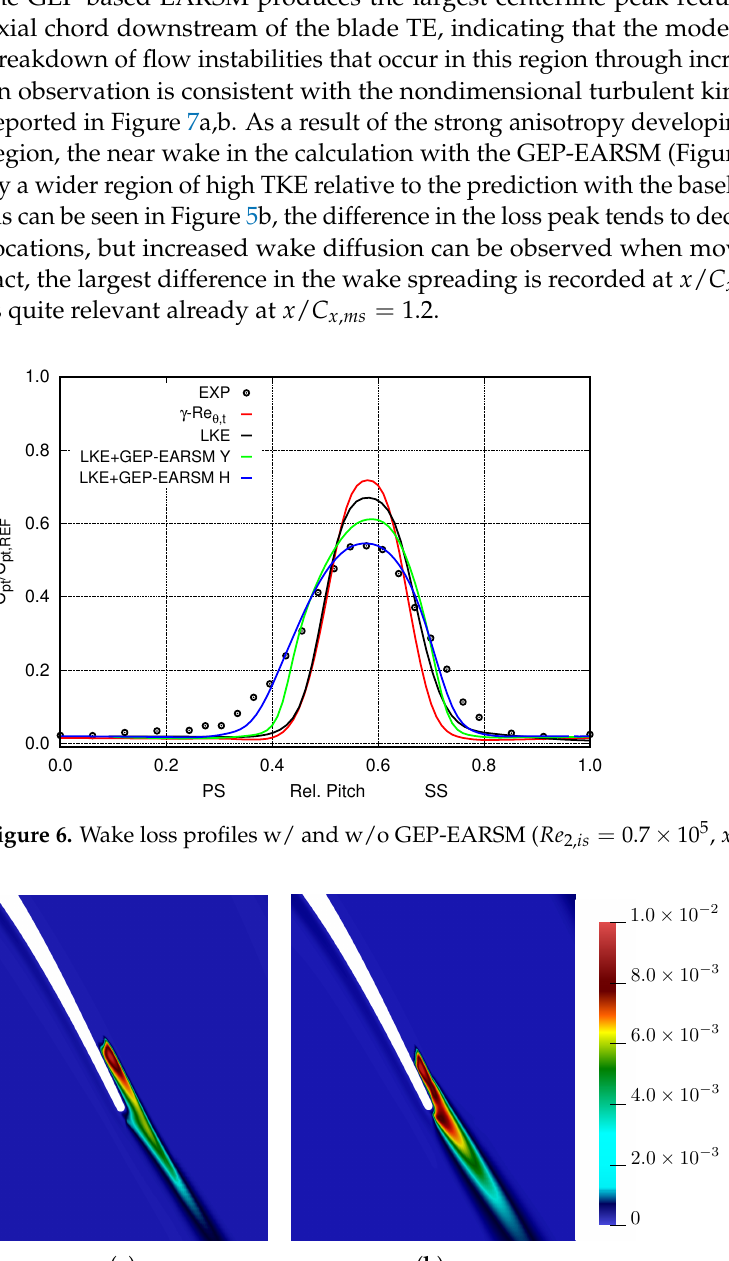
Figure 7. Nondimensional turbulent kinetic energy at midspan ( a ) without GEP-EARSM ( b ) with GEP-EARSM ( Re 2, is = 0.7 10 5 ×